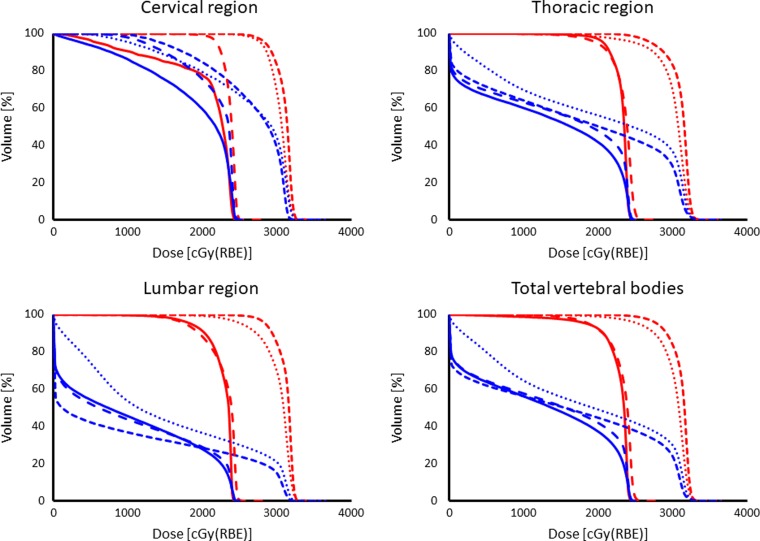
(blue) Actual dose-volume histograms (DVHs) of the vertebral bodies for four AYA patients (case No. 1–4) treated with VBSipCSI. Upper-left; cervical region, upper-right; thoracic region, lower-left; lumbar region, lower-right; total vertebral bodies. (red) DVHs of the simulated plans without VBS which were not used for the patient.